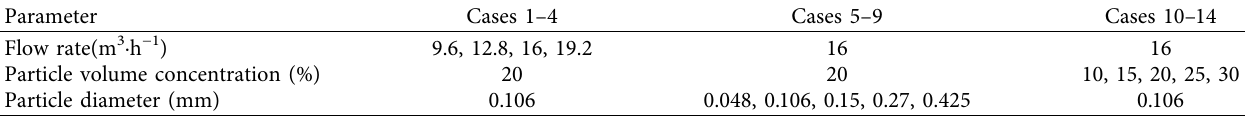
Table 2: Detailed operation